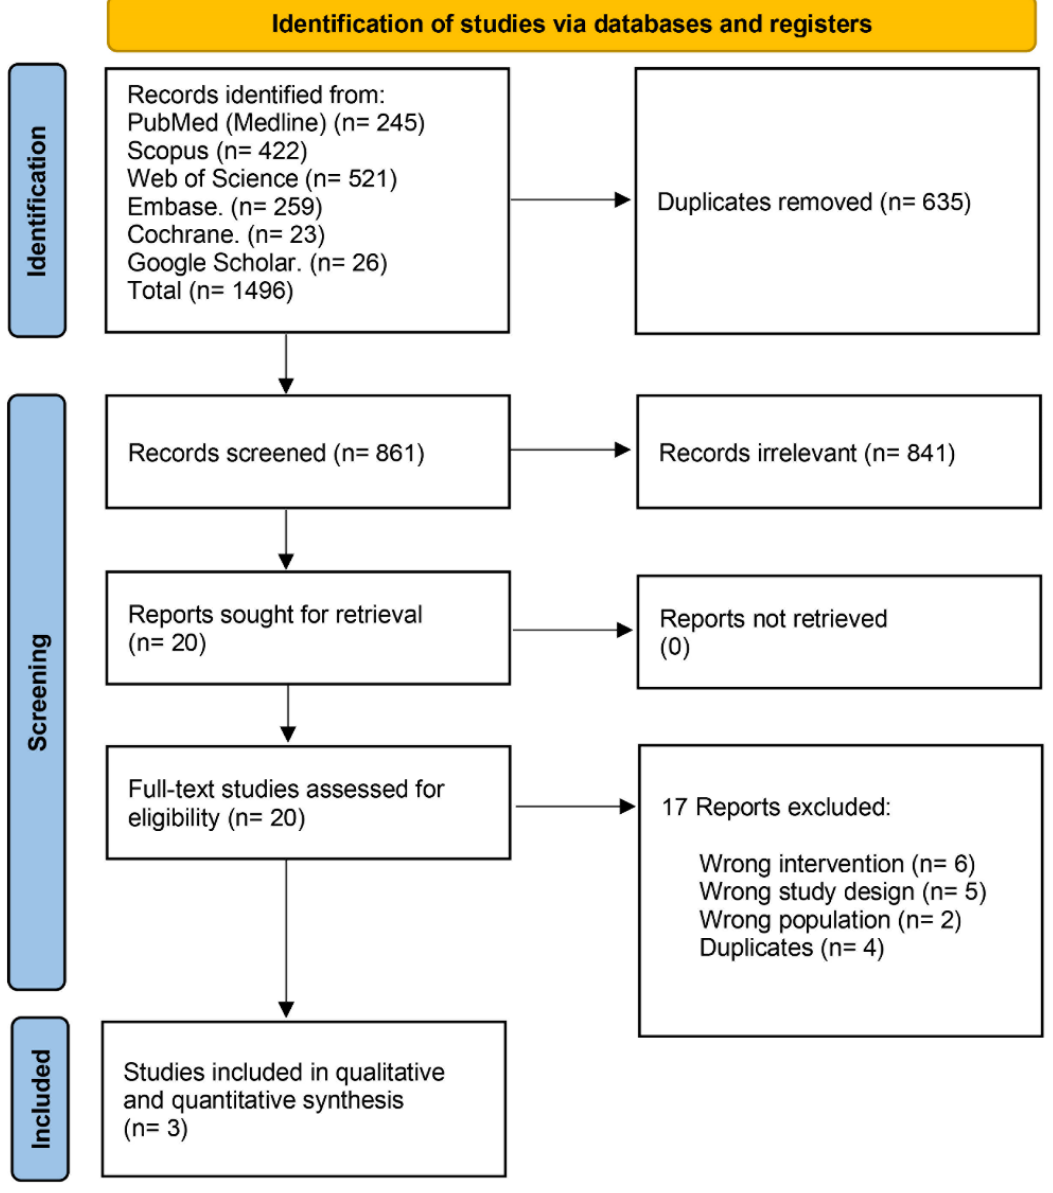
Figure 2. PRISMA flow chart of the screening process.